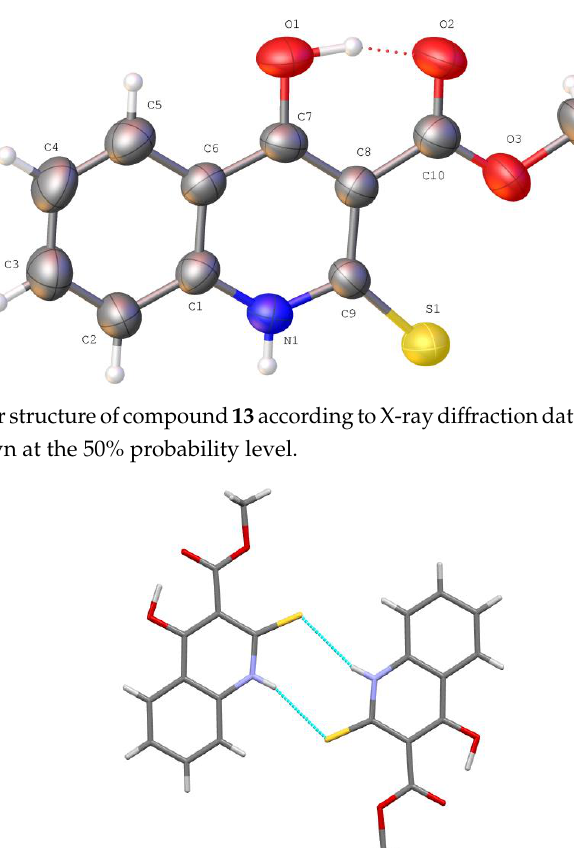
Figure 2. Centrosymmetric dimer of molecules 13 in the crystal phase. Hydrogen bonds are shown by dashed blue lines.